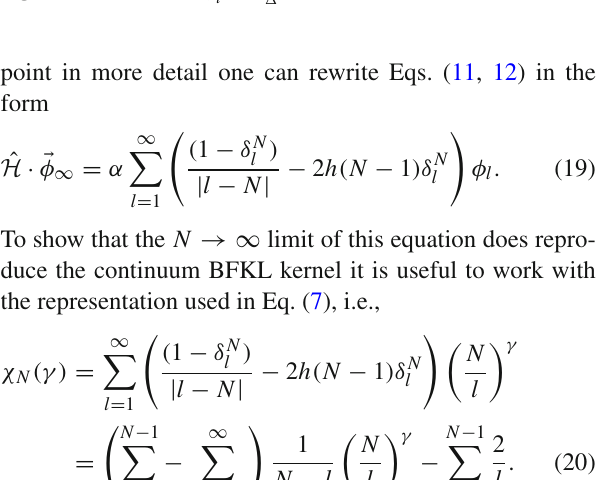
N 0 = δ i (cid:13) with N = 50 and N 0 = 3 i